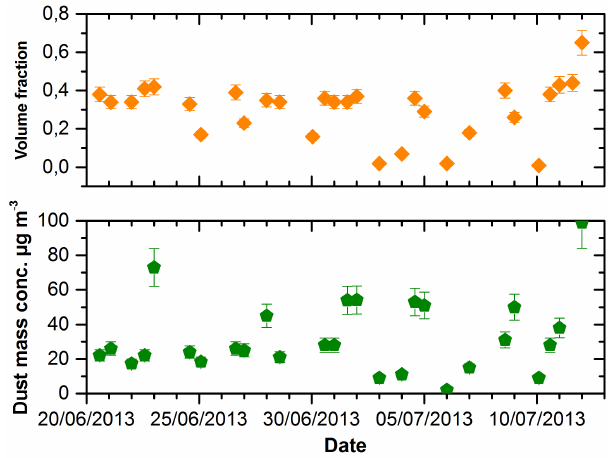
Figure 5. Dust volume fraction (upper panel) and dust mass con- centration (lower panel) within the CMBL over Barbados derived from POLIS lidar measurements. Error bars give the systematical uncertainties resulting from measurement uncertainties and uncer- tainties in the lidar specific input